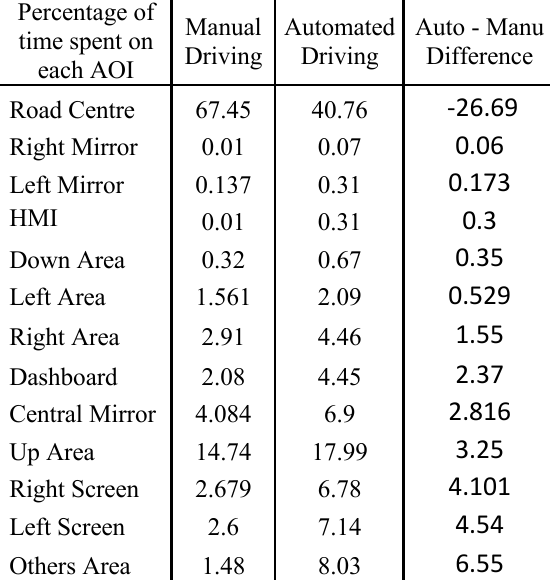
Table 1: Distribution of visual attention for manual and auto- mated